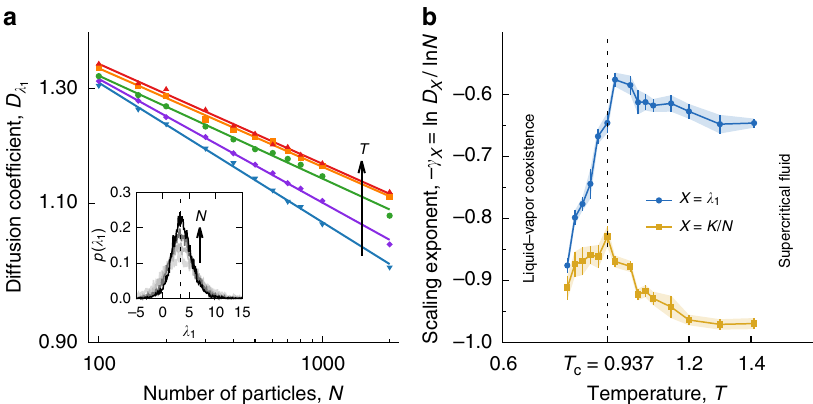
Fig. 3 Finite-size scaling of fl uctuations in dynamical observables. a Fluctuations in the kinetic energy and Lyapunov exponents decay with increasing number of particles (log – log): the diffusion coef fi cients follow a power law D X ð N ; T Þ (cid:3) N (cid:2) γ X ð T Þ for 11 system sizes from N = 100 to 2000. Data shown for λ t ). The corresponding probability distributions also concentrate around the long-time value λ 1 ( T = 0.937). b Wandering exponents, γ X ( T ), of the fi rst fi nite-time Lyapunov exponent and the kinetic energy per particle, K / N , peak at the critical c temperature, T c , at the critical density ρ c . Error bars indicate the standard deviation (1 σ ) for parameter estimates from linear fi ts in for T ≥ T c (Supplementary Fig. 7). While the Lyapunov exponents